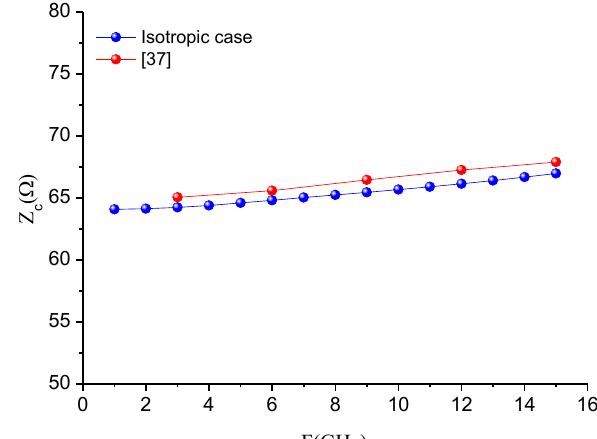
Figure 3: Calculated characteristic impedance compared with